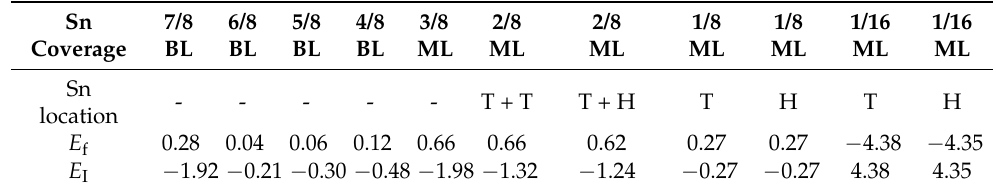
Table 3. Formation energies ( E f in eV per atom) and intercalation energies ( E I in eV) for different Sn coverages.